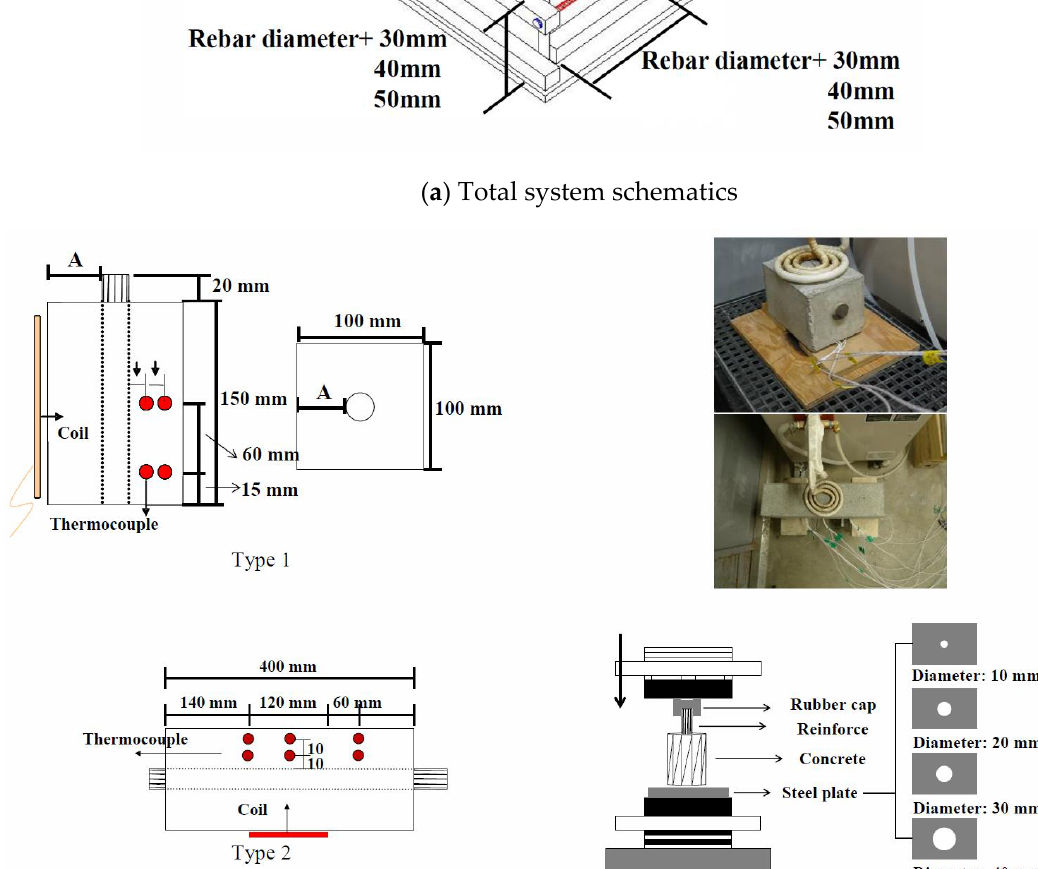
Figure 3. Test specimen production and control method.